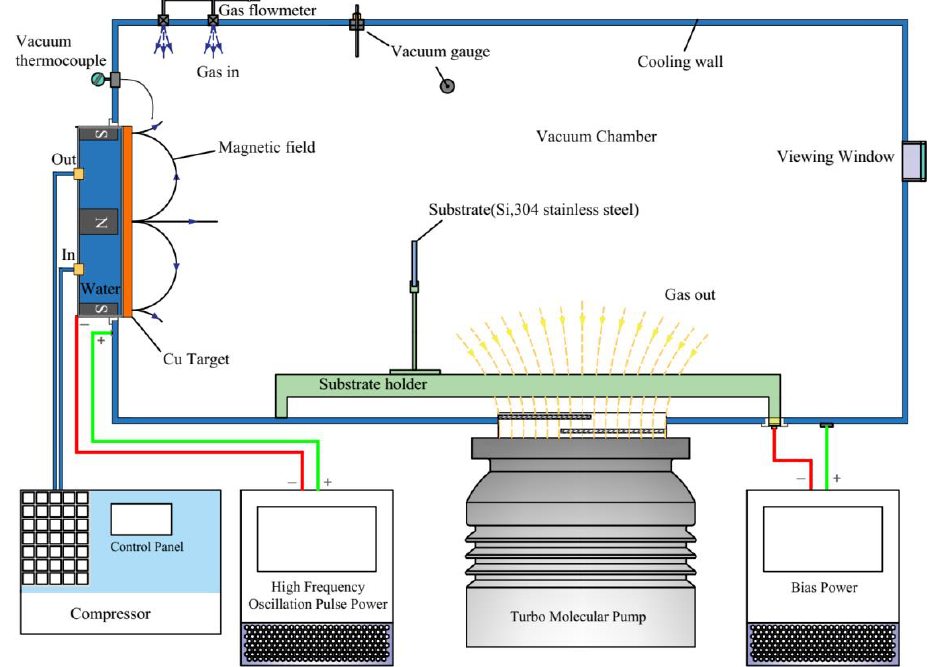
Figure 1. Schematic diagram of the MAIP-001 deposition system.